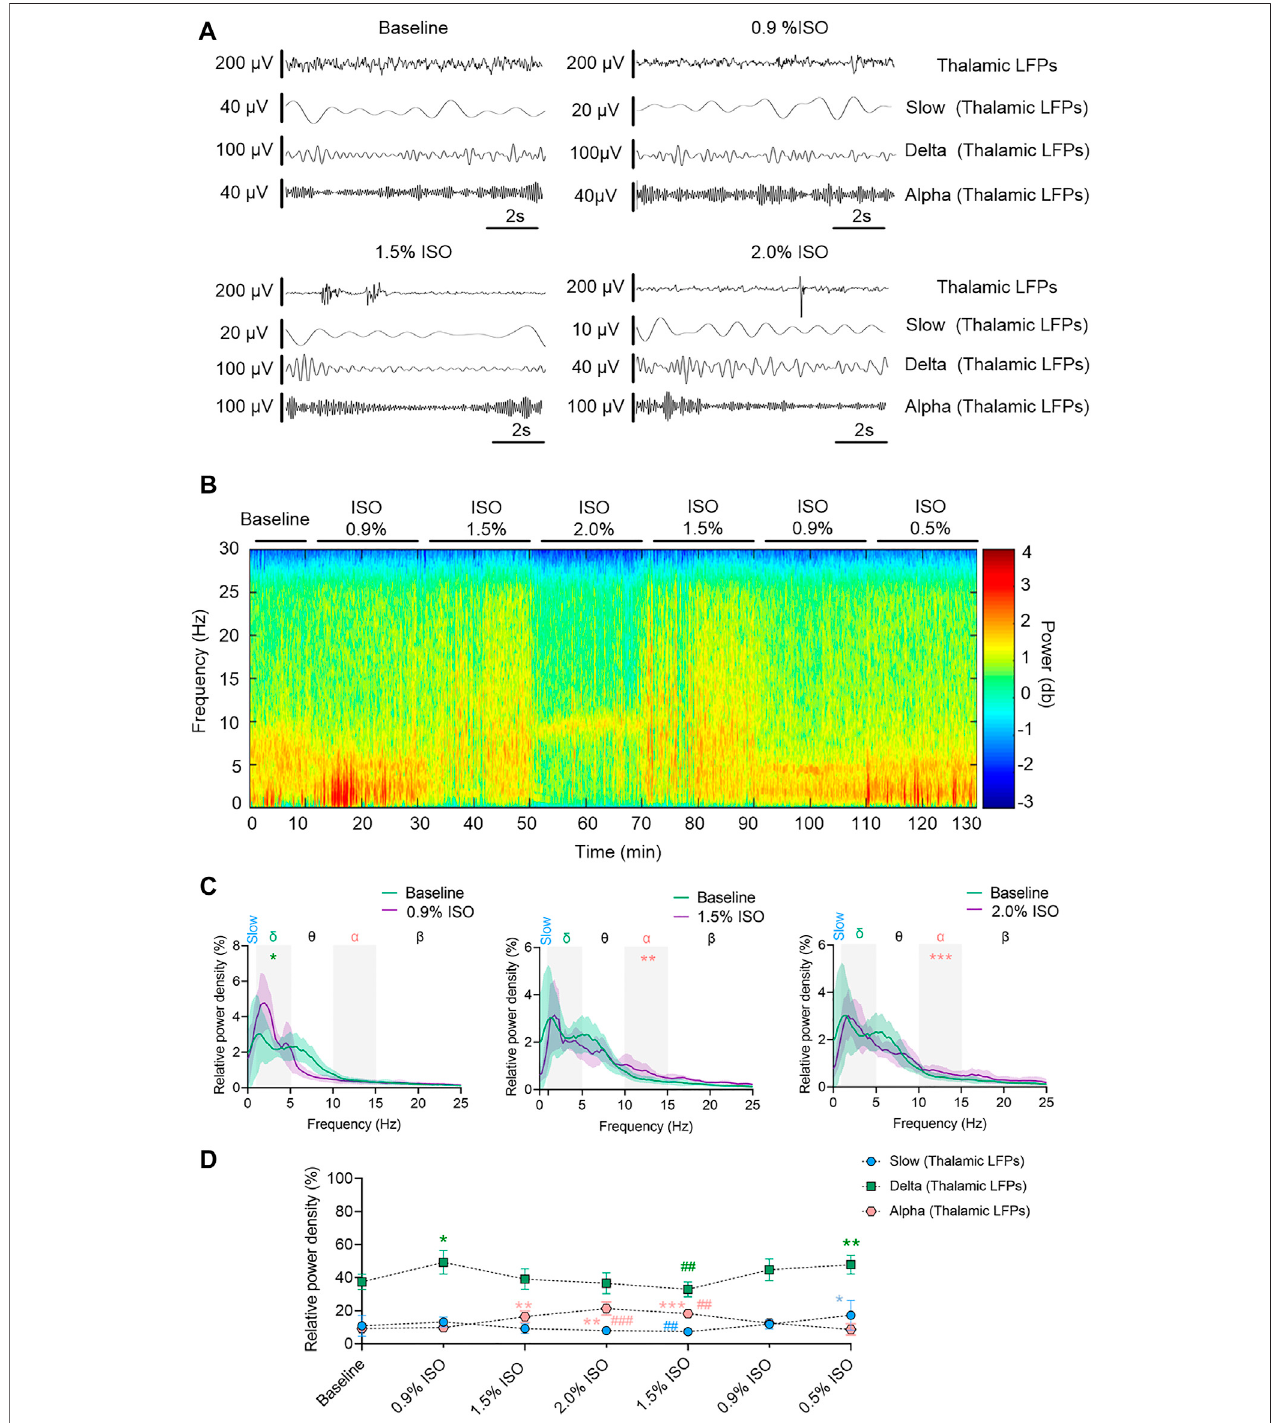
FIGURE2| Dynamics ofthalamicLFPs underiso fl urane anesthesia. (A) Representative rawtracesofthalamic LFPs inslow,delta,and alpha oscillations within the same period. (B) A representative spectrogram of thalamic LFPs. (C) A relative power density of 0.9%, 1.5%, and 2.0% iso fl urane compared with baseline. Shading indicates 95% CI. (D) Total relative power density of thalamic LFPs in slow, delta, and alpha oscillations. Comparisons are based on the repeated-measures ANOVA for all experiments followed by Tukey ’ s post hoc test: * p < 0.05, ** p < 0.001, and *** p < 0.0001 vs. baseline; # p < 0.05, ## p < 0.010, and ### p < 0.001 vs. 0.9%. Frequency oscillations: slow (0.5 – 1 Hz), delta (1 – 5 Hz), and alpha (9 – 14 Hz). LFPs, local fi eld potentials; CI, con fi dence interval; and ISO, iso fl urane.